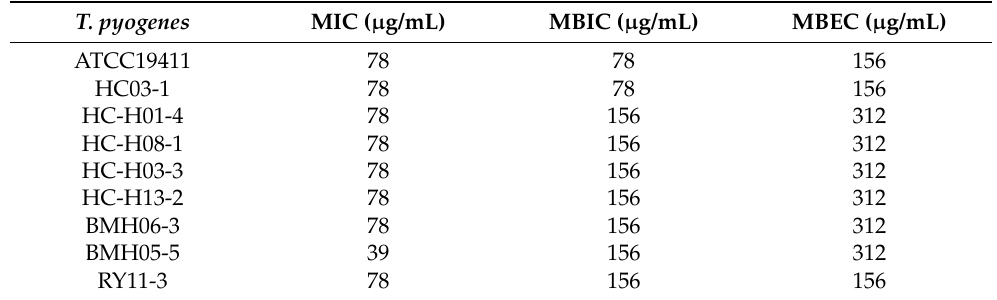
Table 1. Antimicrobial activity and anti-biofilm activity of luteolin against type stain and clinical